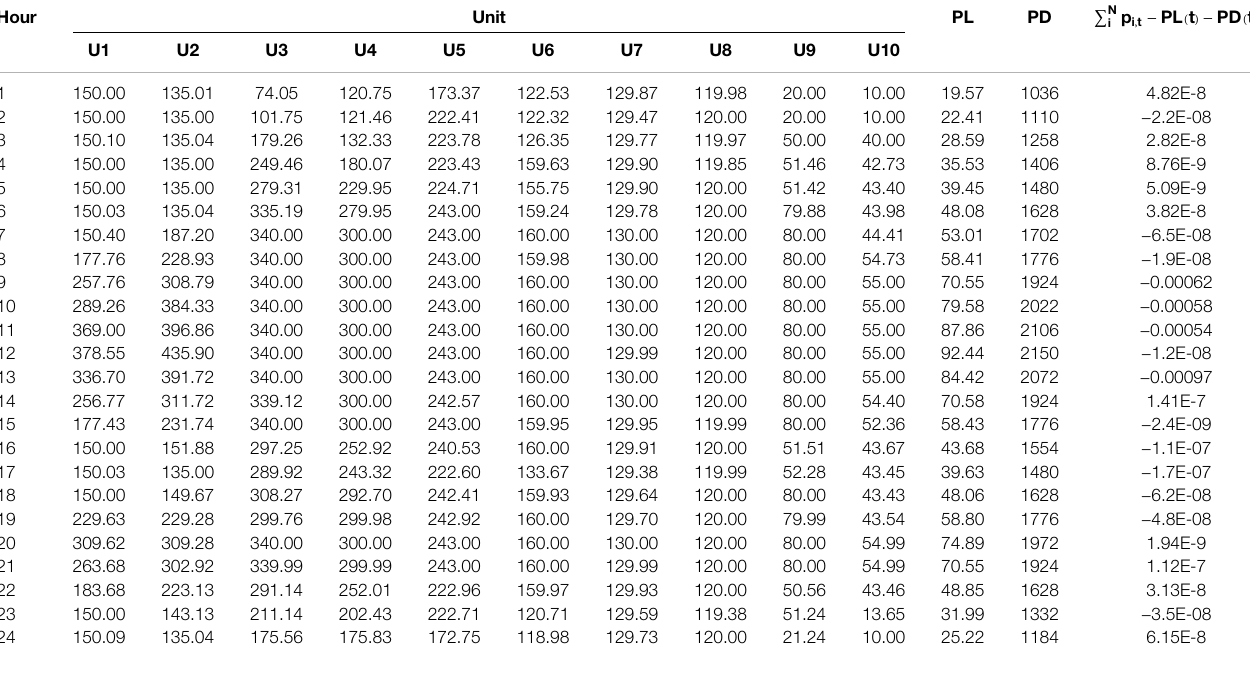
TABLE 11 | The optimal solution information for Case II : only 10-unit power